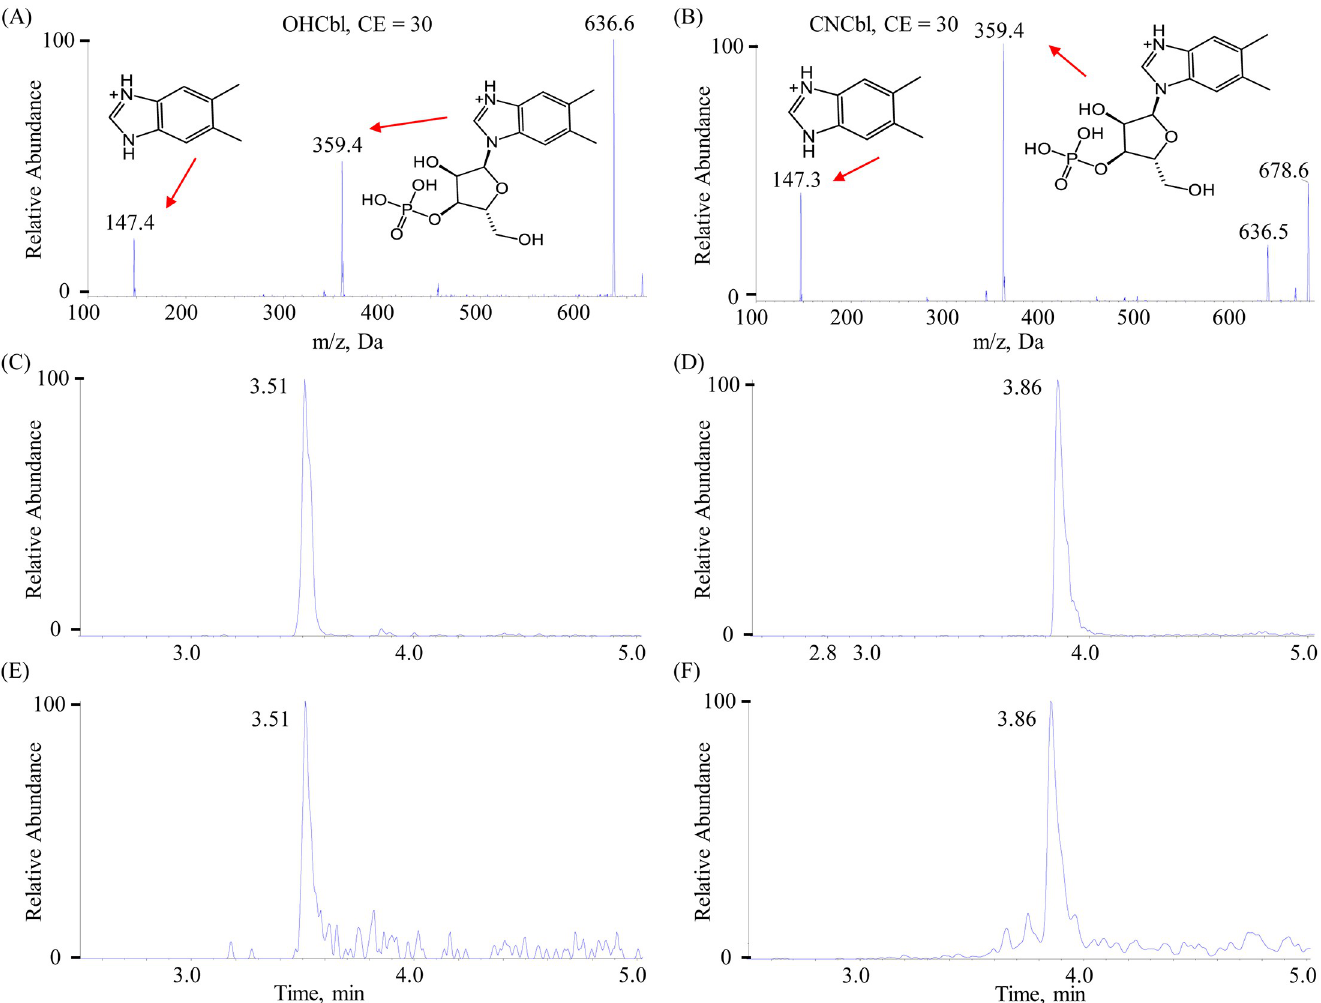
Fig 3. MS/MS spectra of (A) OHCbl and (B) CNCbl. Representative MRM chromatograms of (C) OHCbl and (D) CNCbl in standards. Representative MRM chromatograms of (E) OHCbl and (F) CNCbl in